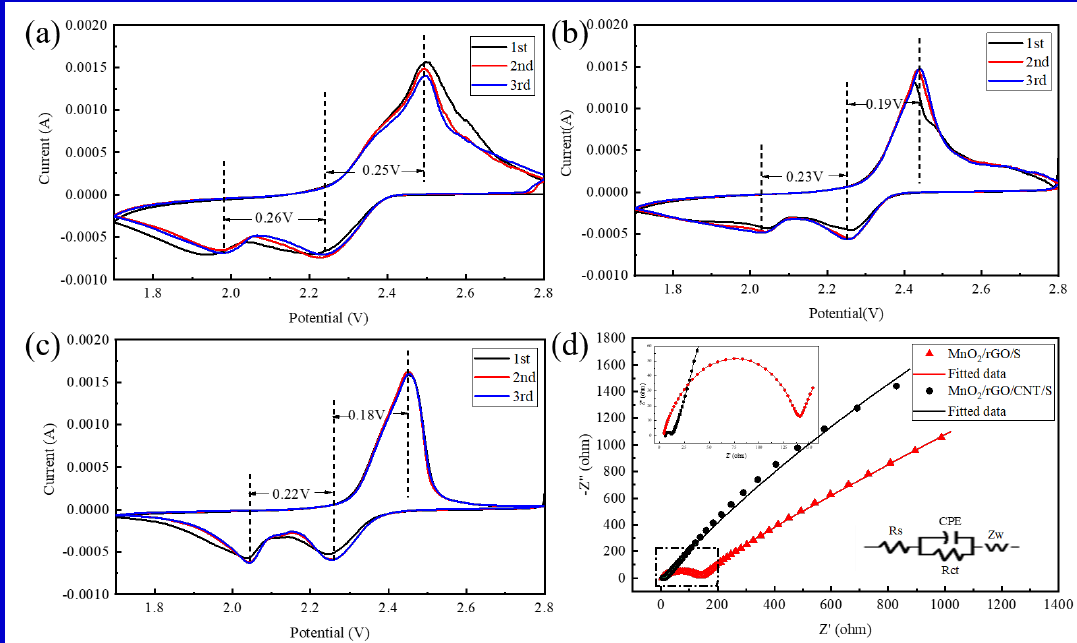
Figure 5. Cyclic voltammograms of rGO/S ( a ), MnO 2 /rGO/S ( b ), and MnO 2 /rGO/CNTs/S ( c ); electrochemical impedance spectroscopy (EIS) curves of MnO 2 /rGO/S and MnO 2 /rGO/CNTs/S ( d ). Table 1. The EIS data of the samples.